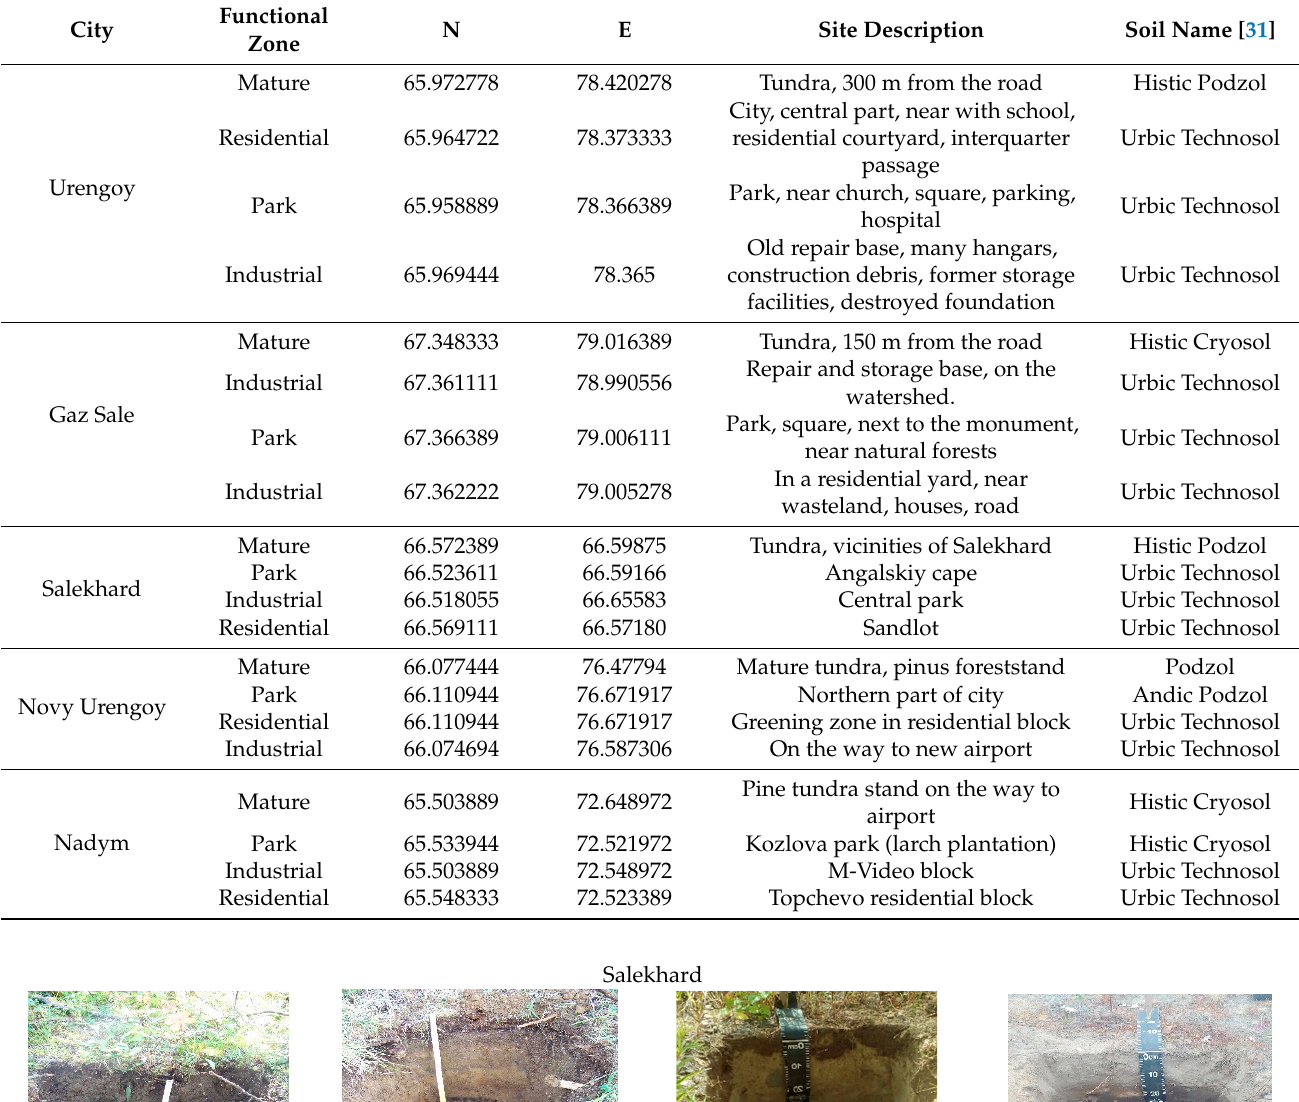
Table 1. Regional settings, site descriptions and soil names for study area.